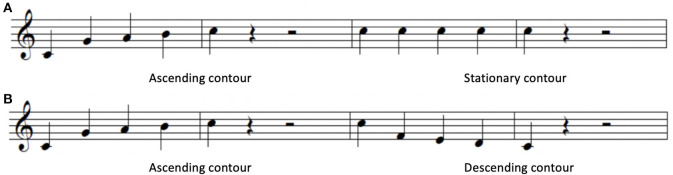
Sample melodic contours. (A) Ascending and stationary contours, (B) ascending and descending contours.